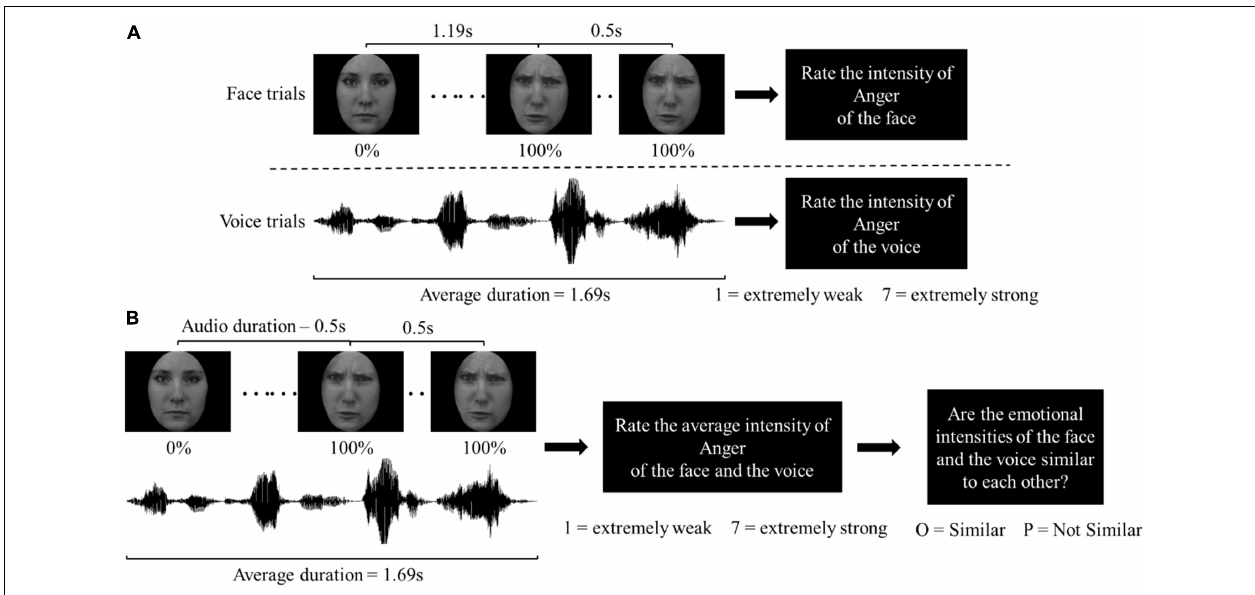
FIGURE 1 | Trial sequence in (A) the unisensory block; (B) the multisensory block. For demonstration purposes, a trial sequence with Strong Angry stimuli is illustrated. In the Weak condition, the duration of each frame was extended accordingly so the face sequence ended at 50% and stayed for 500 ms. In the Neutral condition, the presented face was always 0% Angry/Happy throughout the face